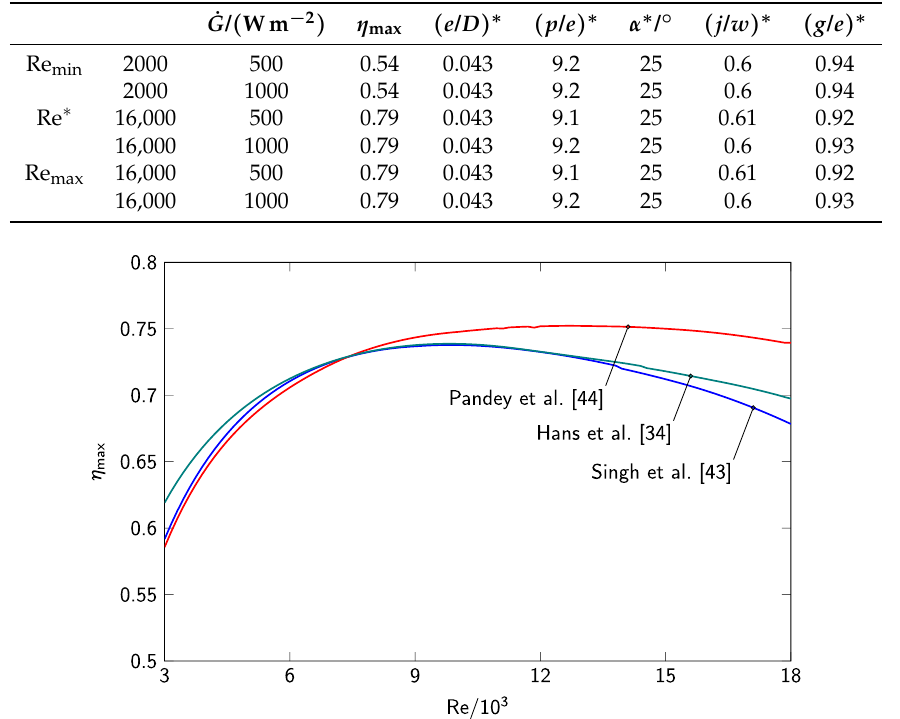
Figure 10. Relationship between η max and Re for absorber plates with curved ribs and ˙ G = 500Wm − 2 .